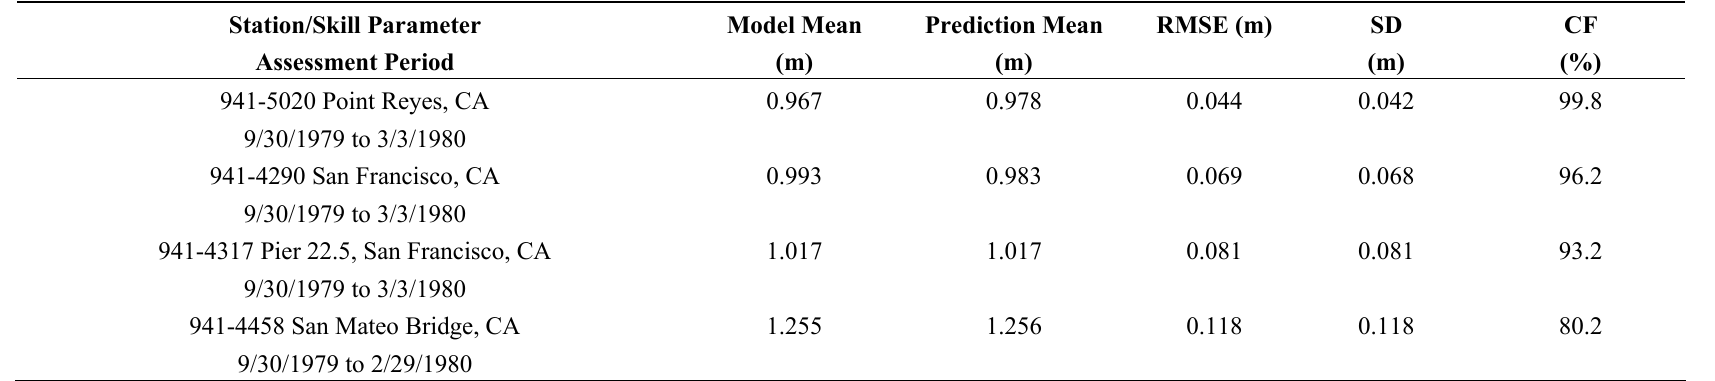
Table 13. Nineteen-month Hindcast Water Level Skill Assessment Results. Results are with respect to MLLWL. RMSE is root mean square error, SD is standard deviation of the error; e.g., model minus observation, and CF is central frequency of the errors with respect to a reference level of 0.15